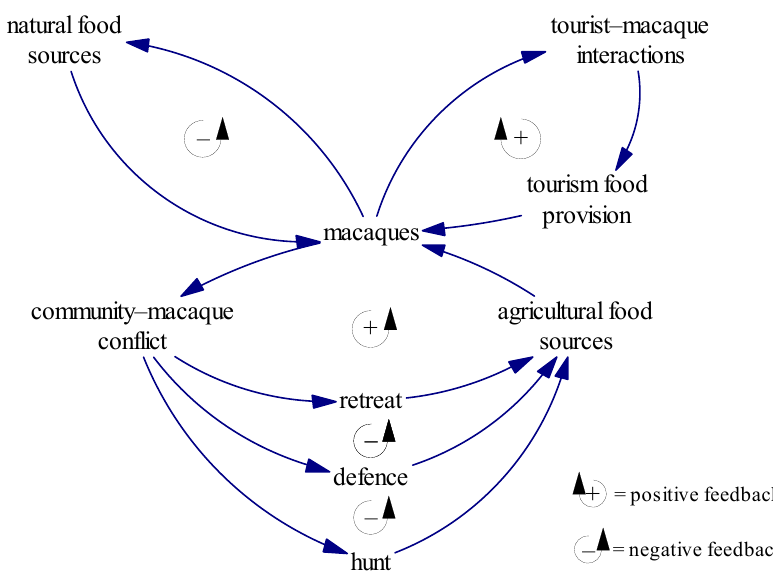
Figure 2. Integrated model of tourism–macaque–community interactions.